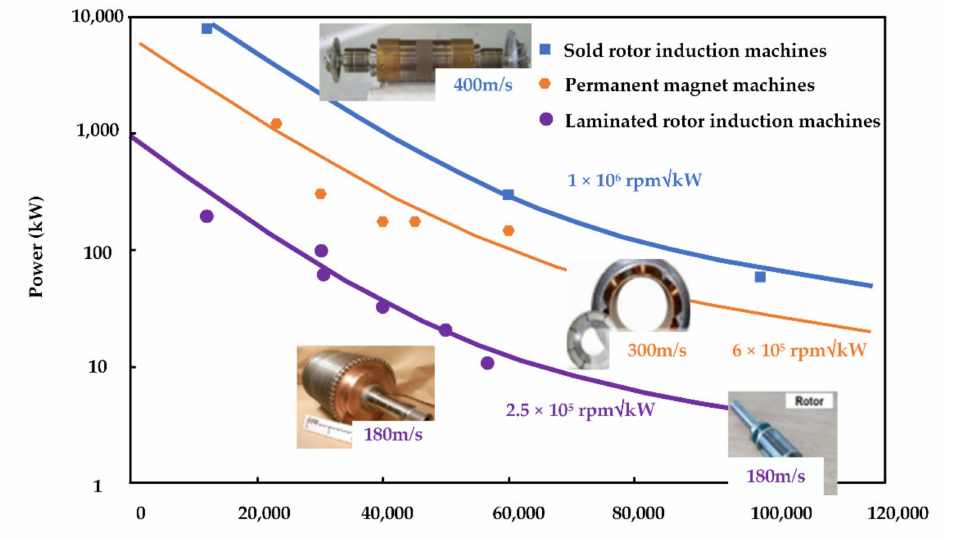
Figure 1. High speed electrical machine